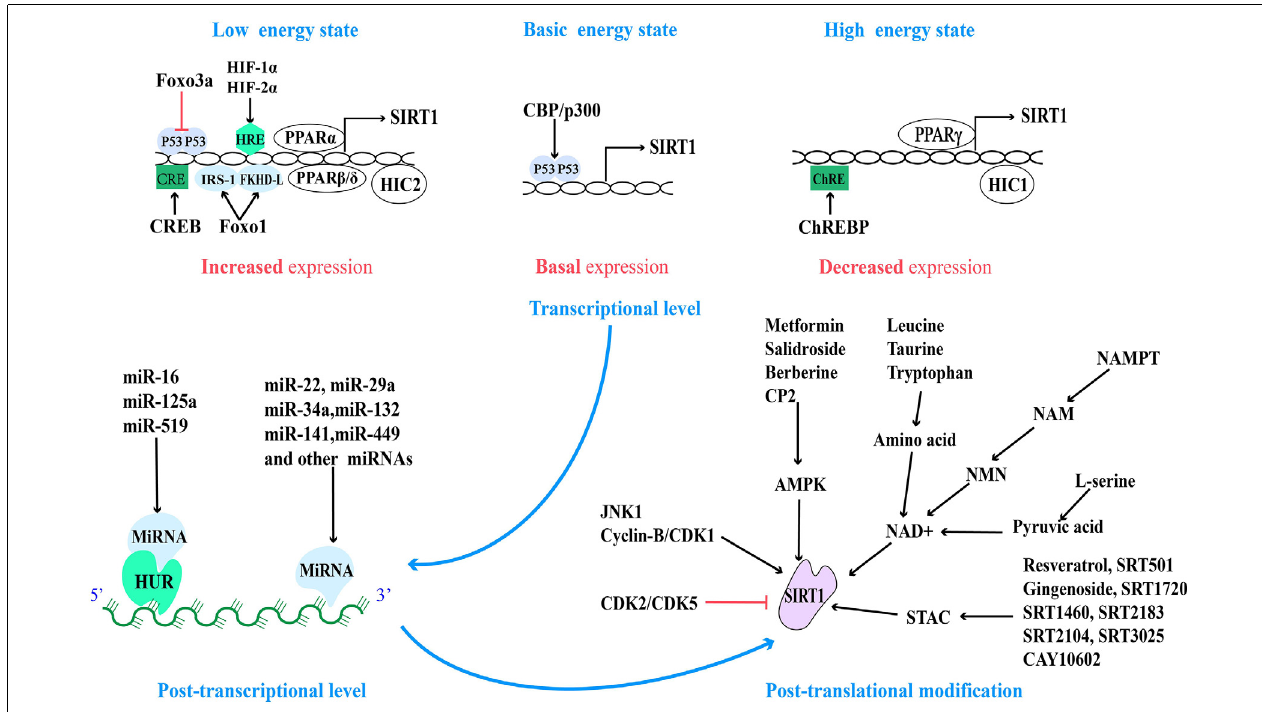
FIGURE 2 | Regulatory sites for SIRT1 protein expression and activity and related pharmacological agents. Based on the different energy states of cells, the activity of the SIRT1 promoter is regulated by a variety of transcriptional regulatory factors. And at the post-transcriptional level, SIRT1 mRNA is regulated by a variety of miRNA. Finally, the activity of post-translational SIRT1 proteins is regulated by different post-translational modification mechanisms.